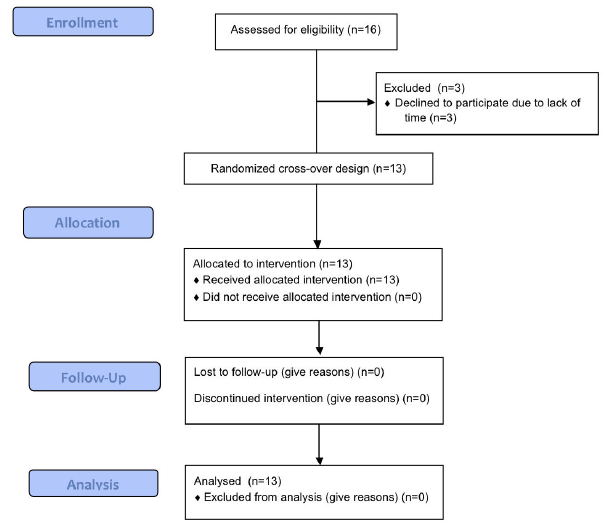
Figure 1. Flow diagram (CONSORT).